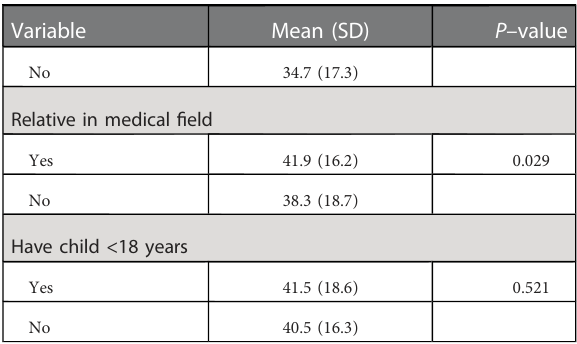
TABLE 3 Basic characteristics by overall knowledge